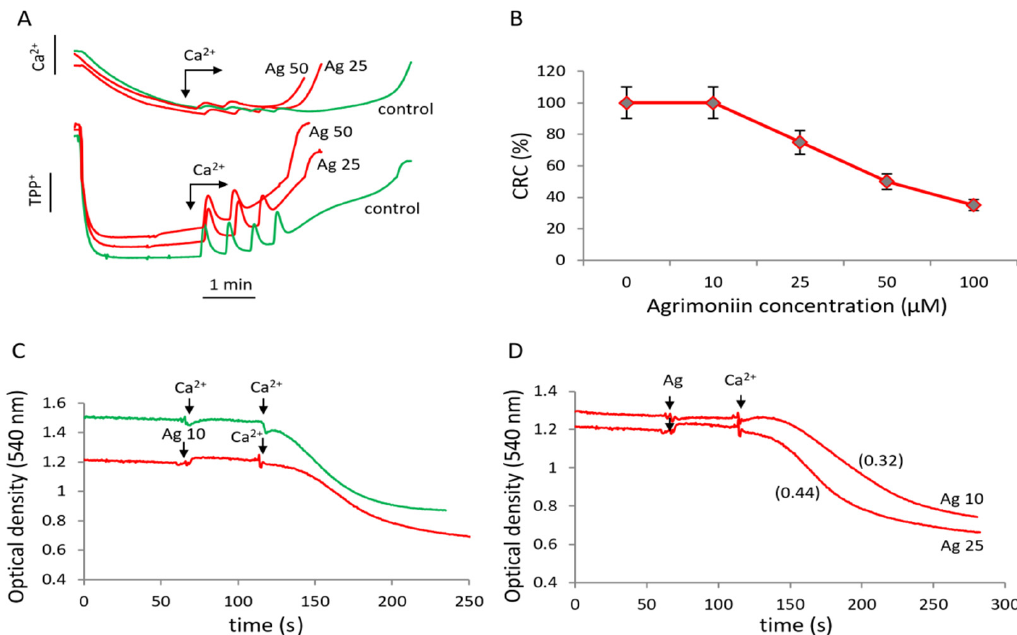
Figure 4. Influence of agrimoniin on MPTP opening induced by calcium ions. ( A )influence of agrimoniin (Ag) on membrane potential (lower curves) and induction of calcium efflux (upper curves) in the course successive CaCl 2 additions of 25 µM each in the control (green curves) and after agrimoniin (25 µM and 50 µM) additions (red curves). ( B )calcium retention capacity (CRC)decreased by agrimoniin at different concentrations; the data represent the average values from five experiments. ( C ) induction of mitochondrial swelling by calcium ions in the control (green curve) and in the presence of 10 µM agrimoniin (red curve). ( D ) swelling rates in the presence of 10 µM and 25 µM agrimoniin. Swelling rates are indicated in parentheses.